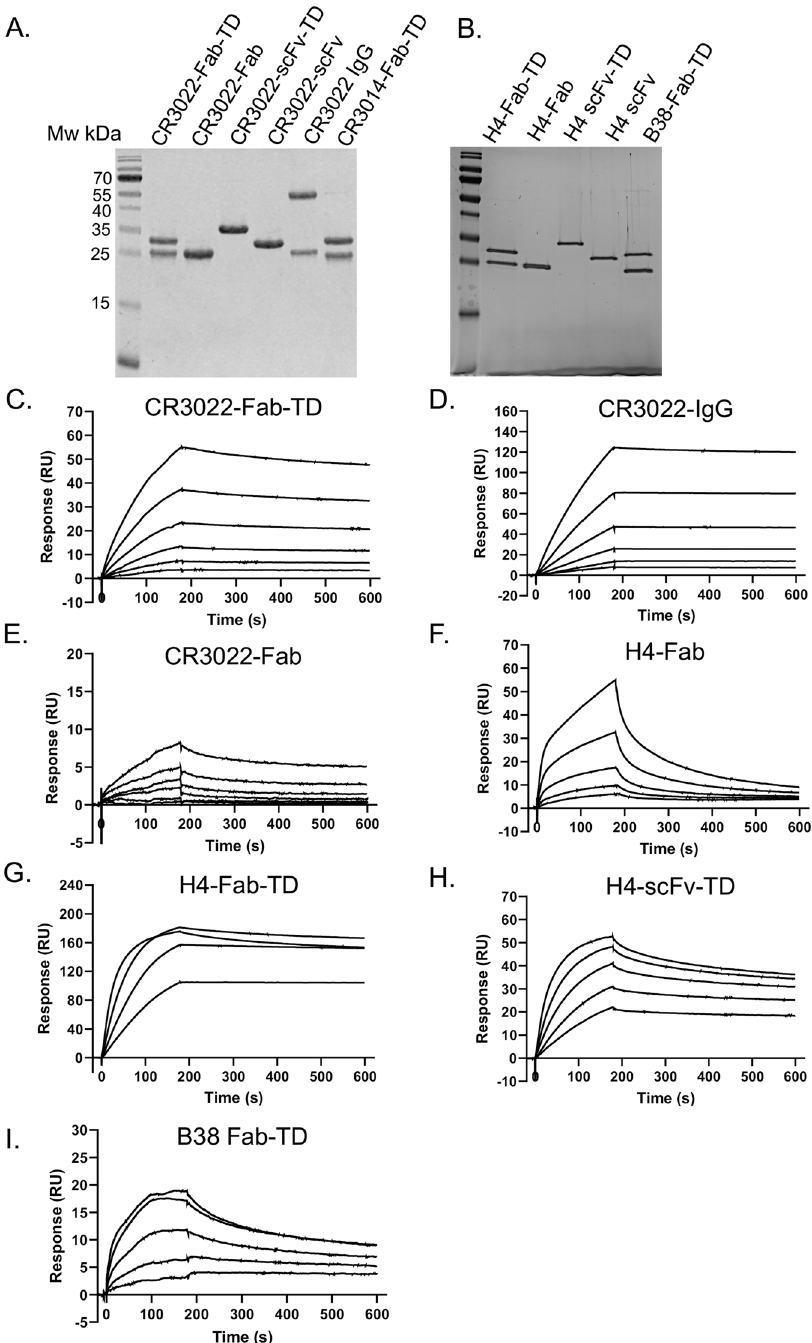
Figure 2. Characterization of anti-SARS-Cov-2 antibodies with different valencies by surface plasmon resonance. The binding potencies of the anti-SARS-Cov-2 tetrameric Quad proteins was determined using surface plasmon resonance. Purified proteins were captured using immobilized SARS-Cov-2 RBD, carried out with a Biacore T200 instrument. (A) Anti-SARS-Cov-2 antibodies were expressed by transfection and secretion from Expi293 suspension cells and